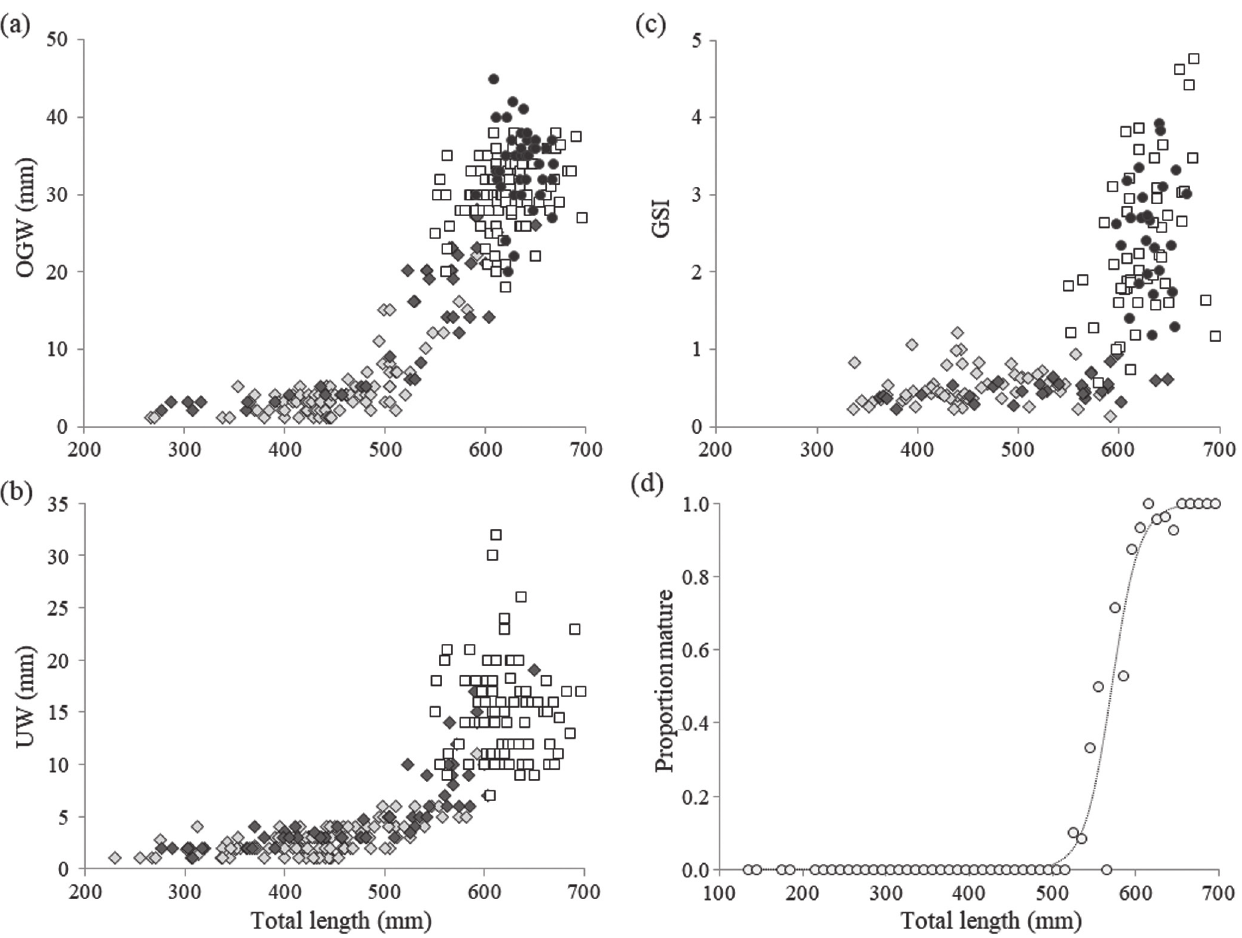
Fig. 5. Relationship between total length and a. oviductal gland width (OGW); b. uterus width (UW); c. GSI; and d. proportion by mature individuals of Atlantoraja cyclophora females according to maturity stage (stage 1, light rhombus; stage 2, dark rhombus; stage 3, light square; stage 4, dark dots). Tab. 2 . Range (mean ± s.d) of the total length (TL, mm) and the reproductive variables recorded for juvenile and adults of Atlantoraja cyclophora . ICL, inner clasper length (mm); ATR, alar thorn rows (nº); TTW, testis weight (g); OGW, oviductal gland width (mm); UW, uterus width (mm); OW, ovary weight (g) and n, sample